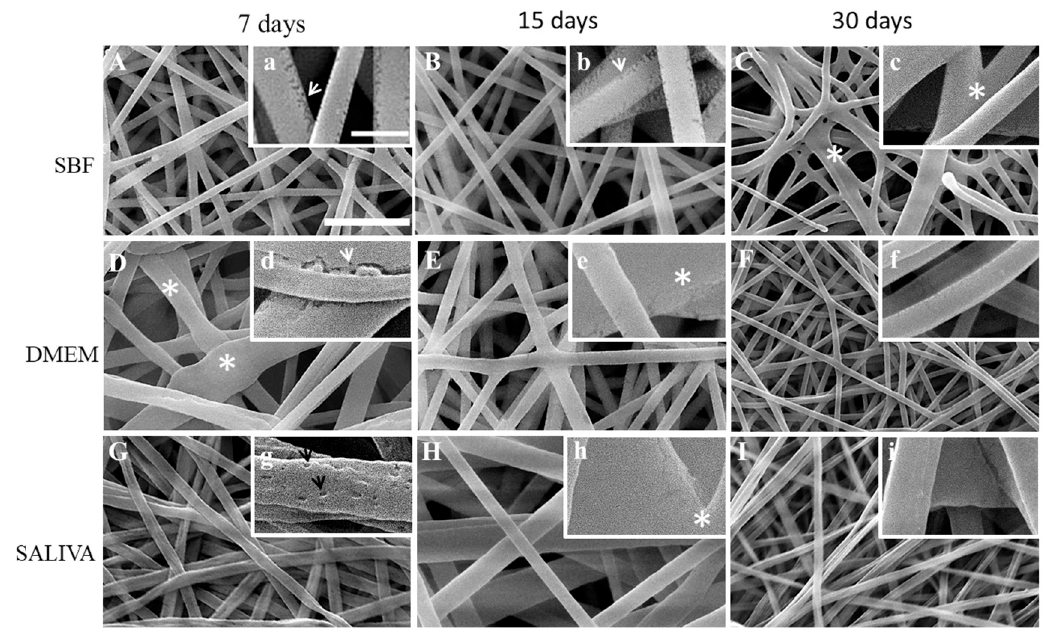
Figure 2. Representative SEM micrographs of non-irradiated electrospun PLGA after immersion in simulated body fluid (SBF), DMEM and saliva for 7, 15 and 30 days. Scale bars: ( A – I ) = 5 µ m; ( a – i ) = 1 µ m. Fibers morphology after 7 and 15 days of immersion in SBF showed borders